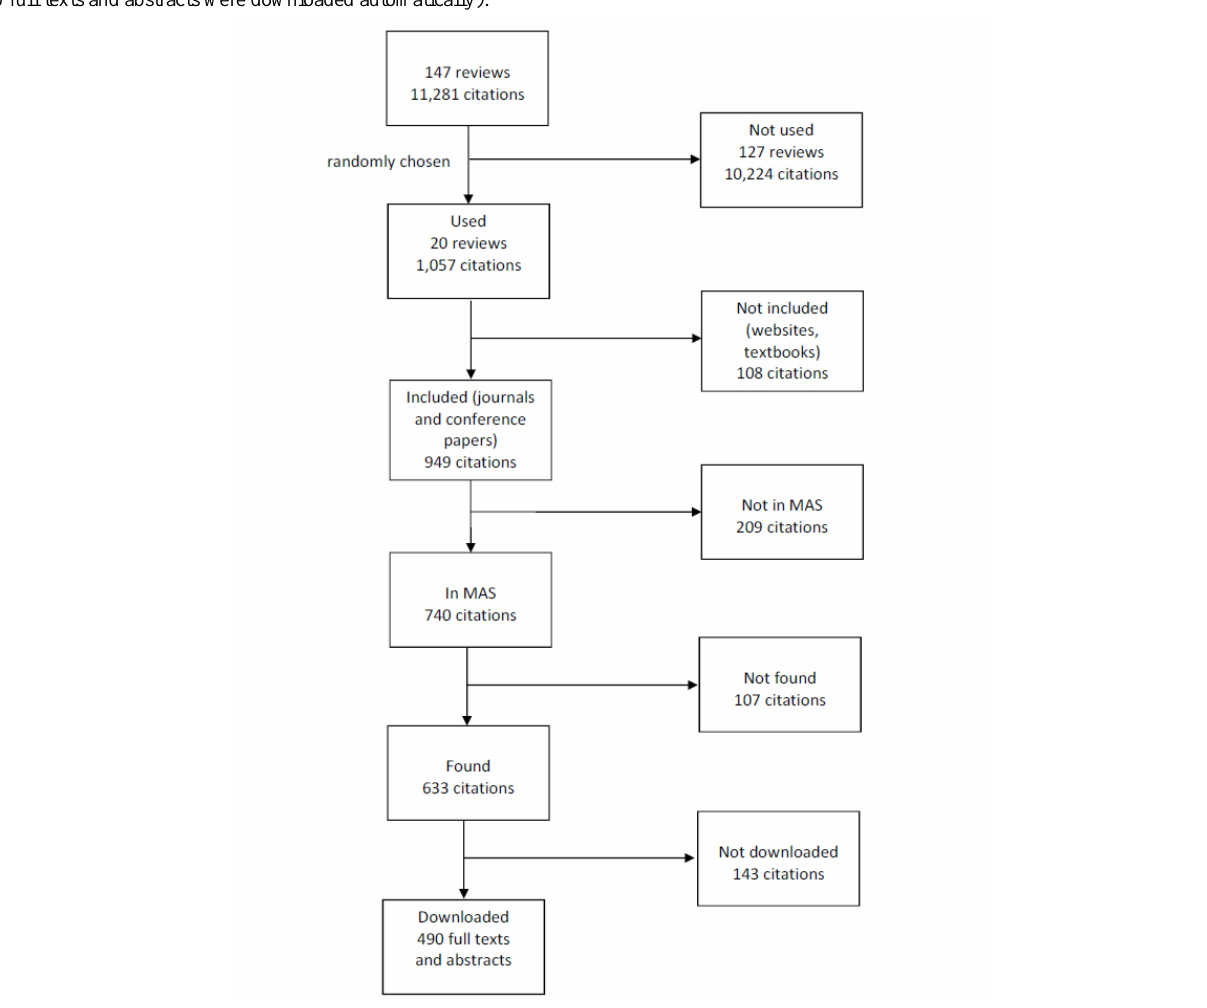
Figure 2. Summary of the evaluation results (from 20 reviews with 949 scholarly citations, MAS included 740 citations, 633 citations were found, and 490 full texts and abstracts were downloaded